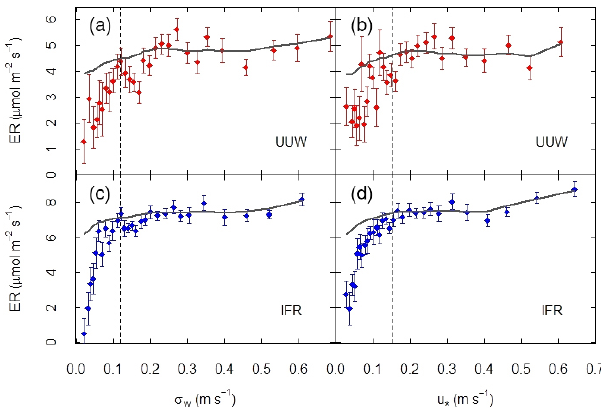
Figure 3. Example of moving-point threshold detection for night- time CO 2 fluxes (ER) for the temperature class 13 to 16 ◦ C (soil temperature at 20mm depth), at the UUW site (top) and the IFR site (bottom). In panels (a) and (c) the standard deviation of vertical wind speed ( σ w ) is used as the discriminating variable, following Acevedo et al. (2009); in panels (b) and (d) , friction velocity ( u ∗ ) is used instead, as is common practice. Bin means and their standard errors are indicated by dots with error bars. The solid line marks 0.99 times the mean of all bin means to the right of the actual bin. The vertical dashed lines indicate the overall optimum threshold choices for σ w and u ∗